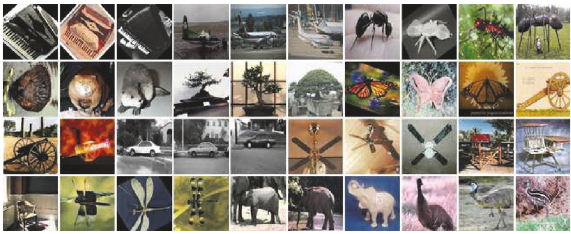
Figure 7: Examples of the Caltech101 database.